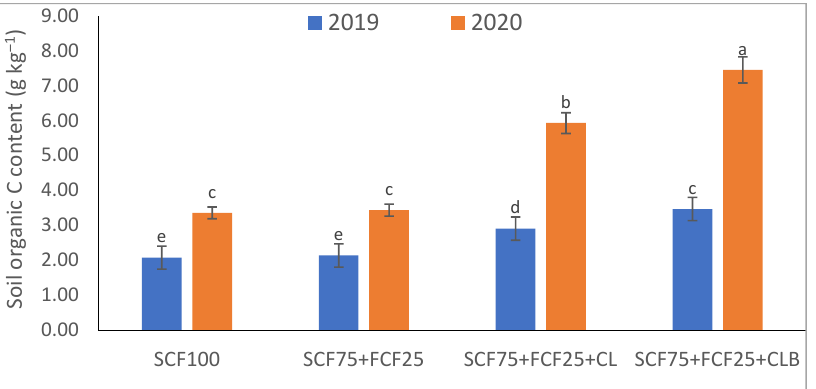
Figure 3. Response of soil enzyme activities (cellulase) to different fertilization strategies applied in two seasons (2019 and 2020) to sandy soil. Abbreviations of fertilization treatments are explained in Table 1. Bars with a different letter indicate significant difference between treatments at p ≤ 0.05.